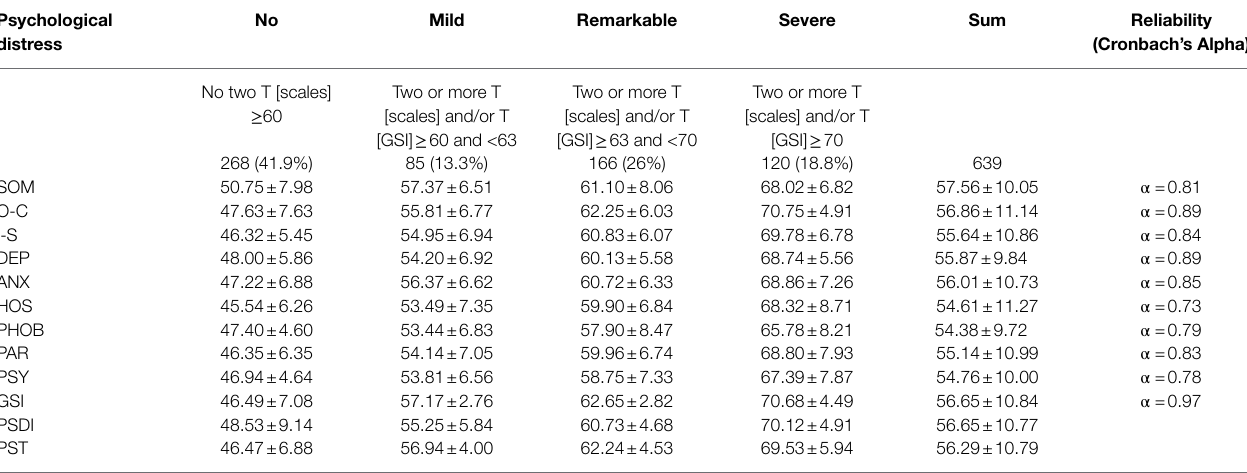
TABLE 2 | BSI profile of the four different psychologically distressed groups (T-scores; mean and standard deviation).